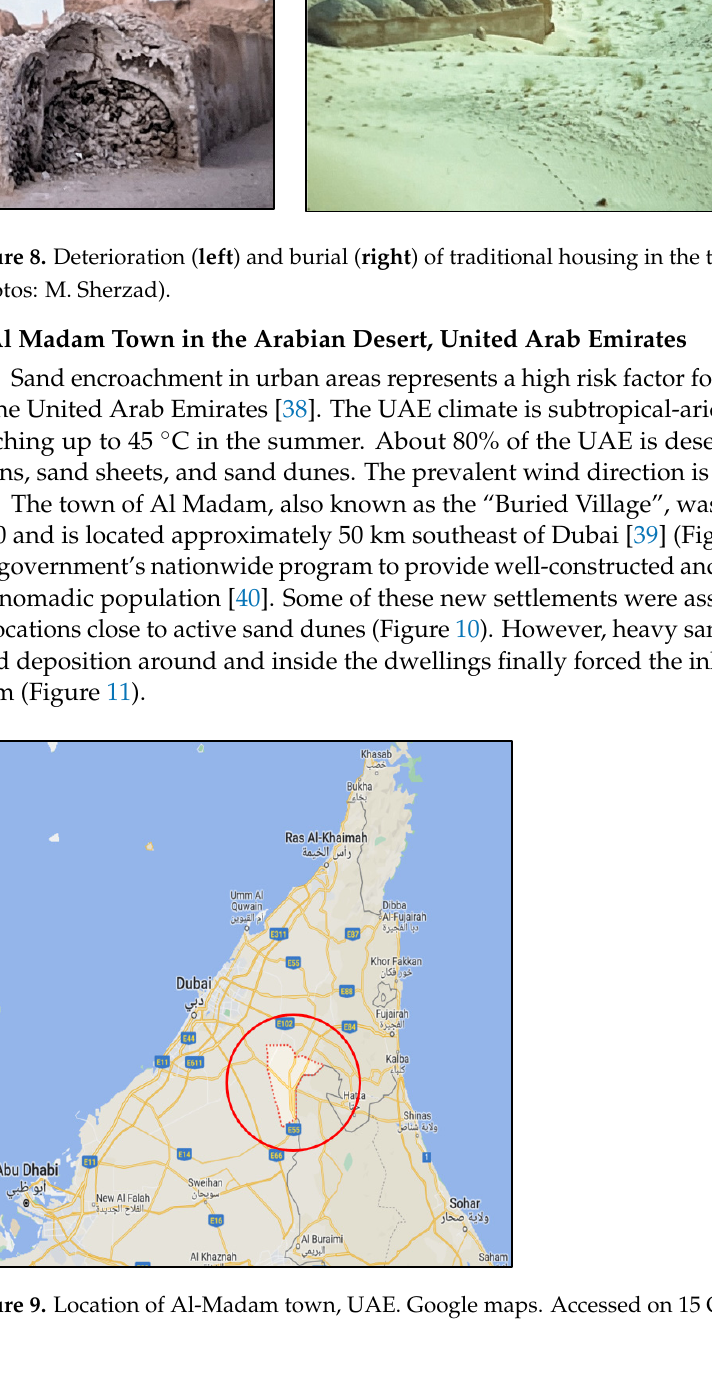
Figure 10. Aerial view of the Al ‐ Madam housing project. Credit: Shutterstock.com (accessed on 8 November 2022).